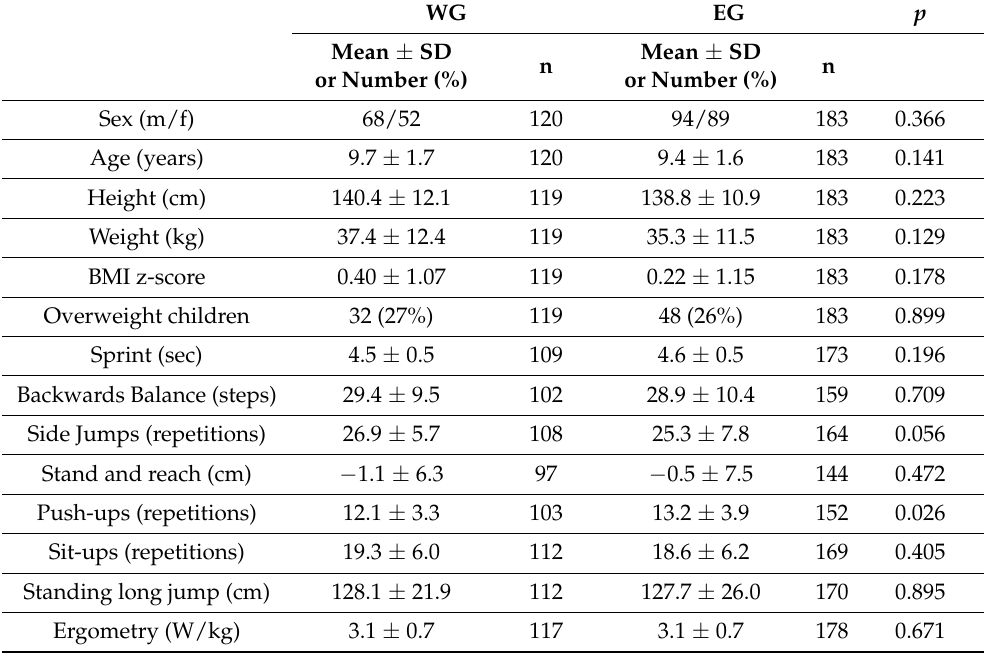
Table 1. Baseline characteristics of the exercise group and waiting